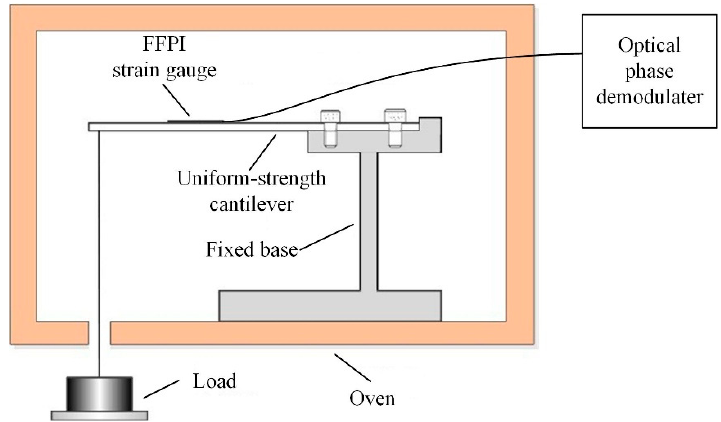
Figure 6. Measurement setup of the FFPI strain gauge.